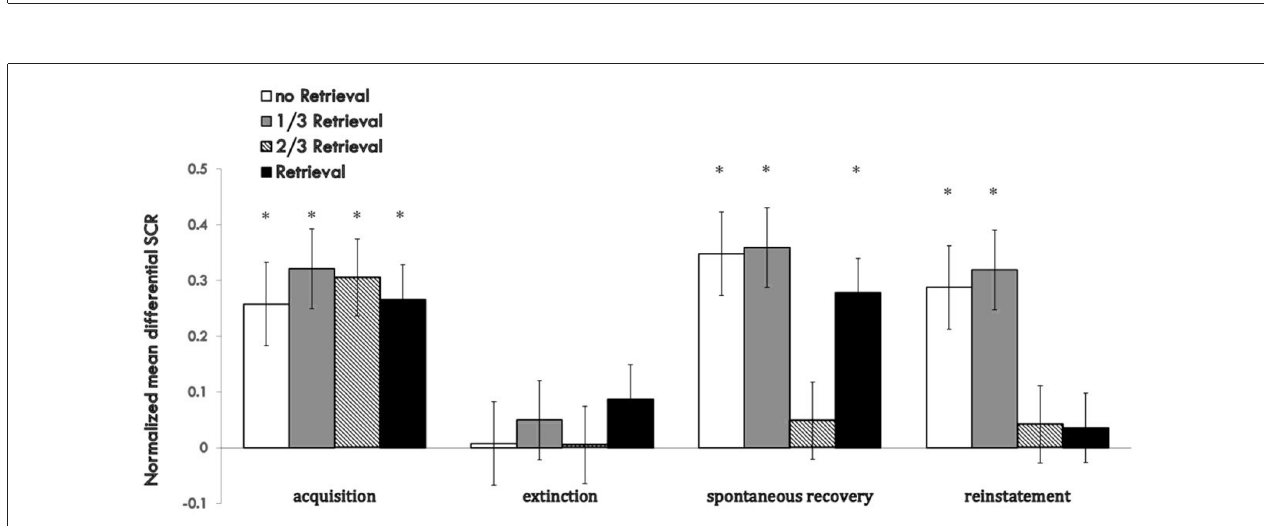
FIGURE 5 | Mean differential SCRs to CS during acquisition, reactivation, extinction, spontaneous recovery test and reinstatement test in each group. ∗ p < 0.05 (between acquisition and extinction, or between extinction and re-extinction within group). Error bars represent standard